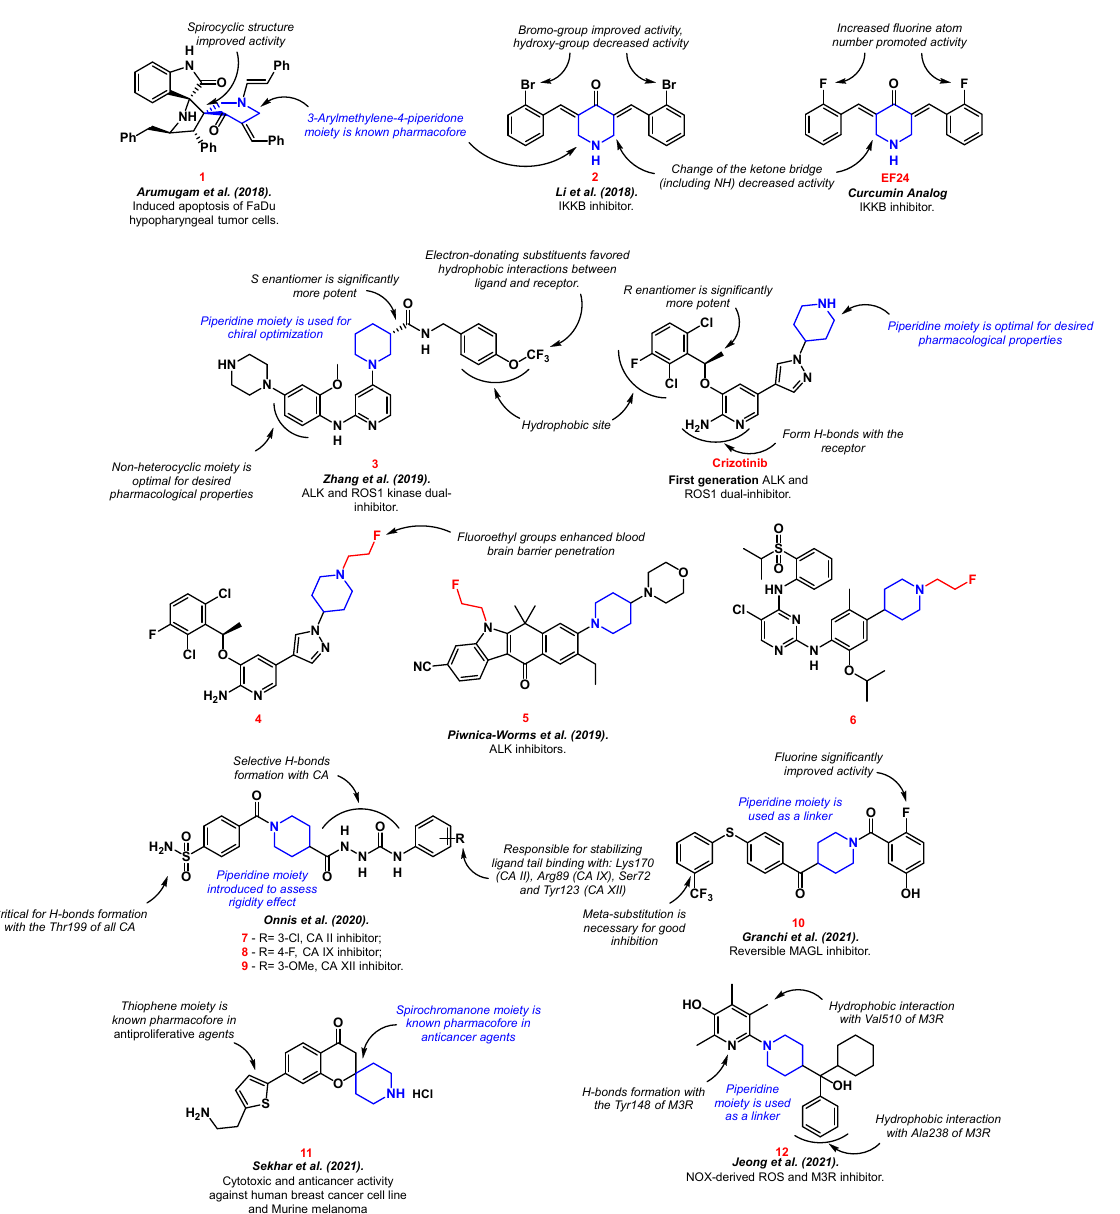
Figure 5. Structure–activity relationship of piperidine derivatives with anticancer activity [207,214,218,223,224,225,230,231,233,234].